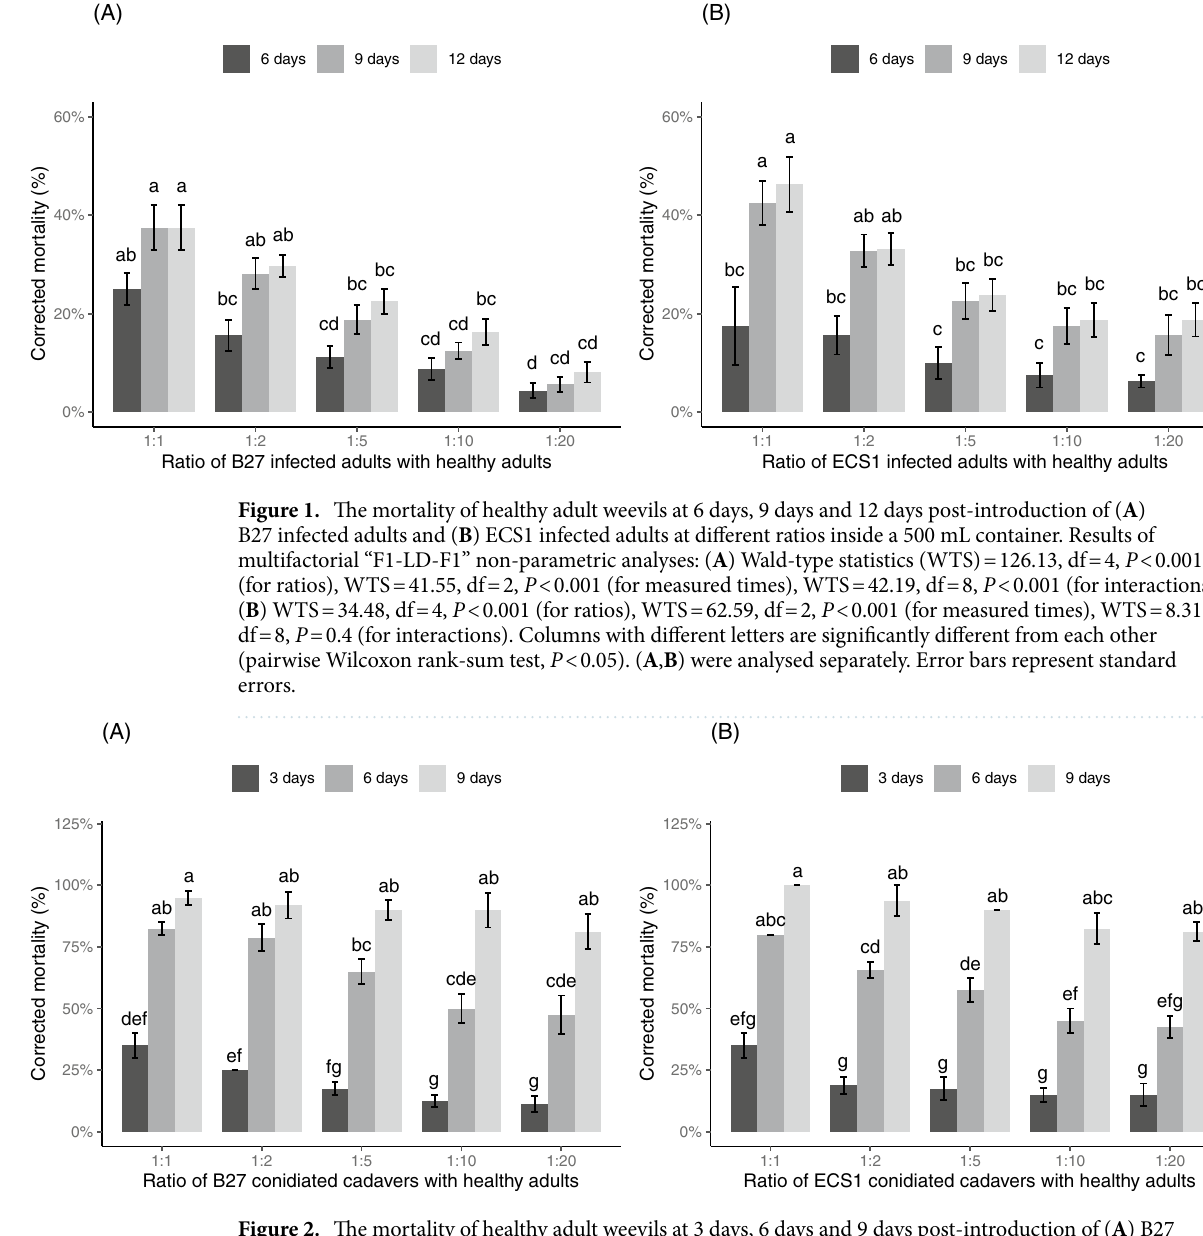
Figure 2. The mortality of healthy adult weevils at 3 days, 6 days and 9 days post-introduction of ( A ) B27 conidiated cadavers and ( B ) ECS1 conidiated cadavers at different ratios inside a 500 mL container. Results of multifactorial “F1-LD-F1” non-parametric analyses: ( A ) Wald-type statistics (WTS) = 47.57, df = 4, P < 0.001 (for ratios), WTS = 436.53, df = 2, P < 0.001 (for measured times), WTS = 10.64, df = 8, P = 0.22 (for interactions), ( B ) WTS = 93.85, df = 4, P < 0.001 (for ratios), WTS = 581.02, df = 2, P < 0.001 (for measured times), WTS = 24.45, df = 8, P < 0.01 (for interactions). Columns with different letters are significantly different from each other (pairwise Wilcoxon rank-sum test, P < 0.05). ( A , B ) were analysed separately. Error bars represent standard mortality to healthy adults at all measured times but in contrast to B27 mortality was significantly higher than the three lowest ratios only at 6 days post-introduction (Fig. 2B, P < 0.05). Horizontal infection from conidiated cadavers to healthy adults in an insect cage. The mortal- ity of healthy adults was significantly influenced by the ratio of the conidiated cadavers ( P < 0.05), time ( P < 0.05) and their interactions ( P < 0.05) for both fungal species. The pairwise Wilcoxon rank-sum test for multiple com- parisons showed that the highest ratio of B. bassiana strain B27 conidiated cadavers (ratio 1:1) caused the highest mortality to healthy adults across all measured times, and was significantly higher than the three lowest ratios (1:5, 1:10, 1:20) at 12 days and the two lowest ratios at 18 days post-introduction (Fig. 3A, P < 0.05). For M. anisopliae strain ECS1, the highest ratio of the conidiated cadavers (1:1) also caused the highest mortality to